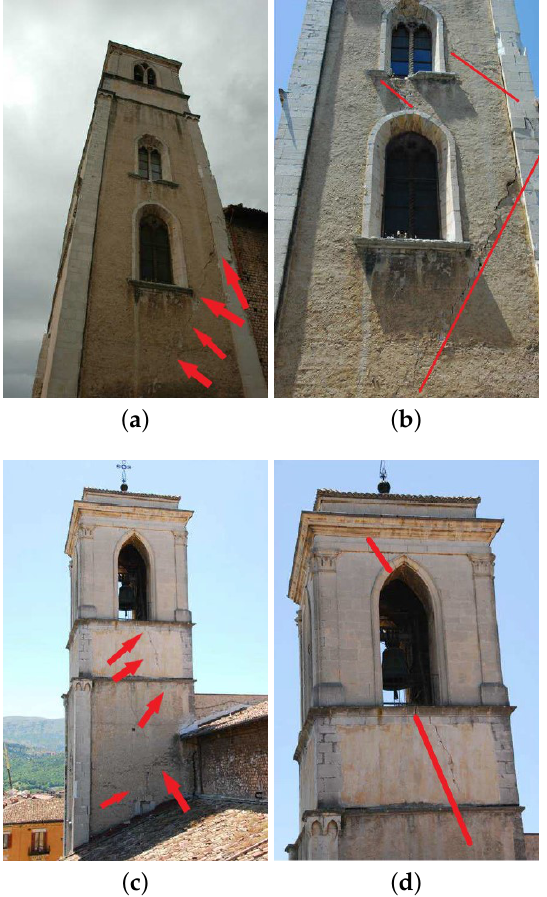
Figure 13. Views of the St.Silvestro belfry after the 2009 earthquakes: red lines and arrows points out the damage pattern (taken by Fine Art Authority): ( a , b ) cracks pattern along the stem of the belfry; ( c , d ) cracks pattern along the stem of the bell